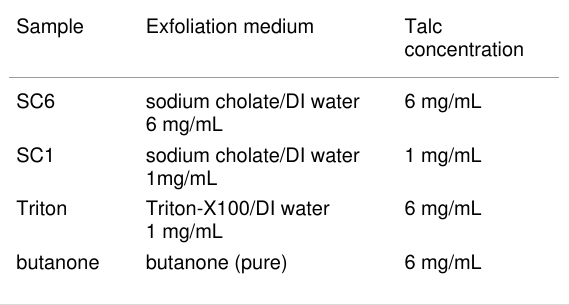
Table 1: Initial concentration of talc and surfactants/organic solvents for exfoliation.